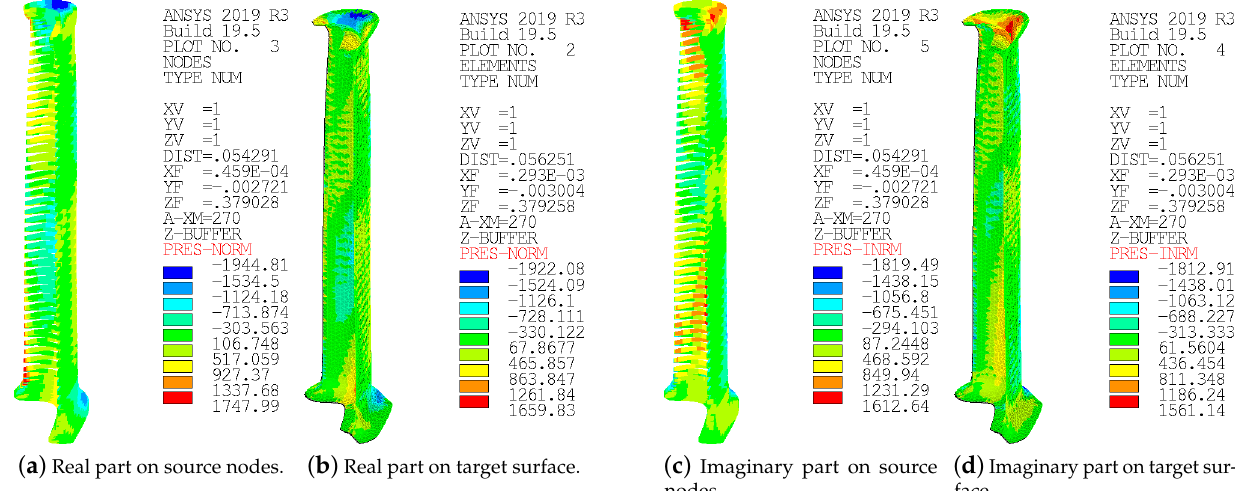
Figure 15. Check on forcing distribution mapping (EO =